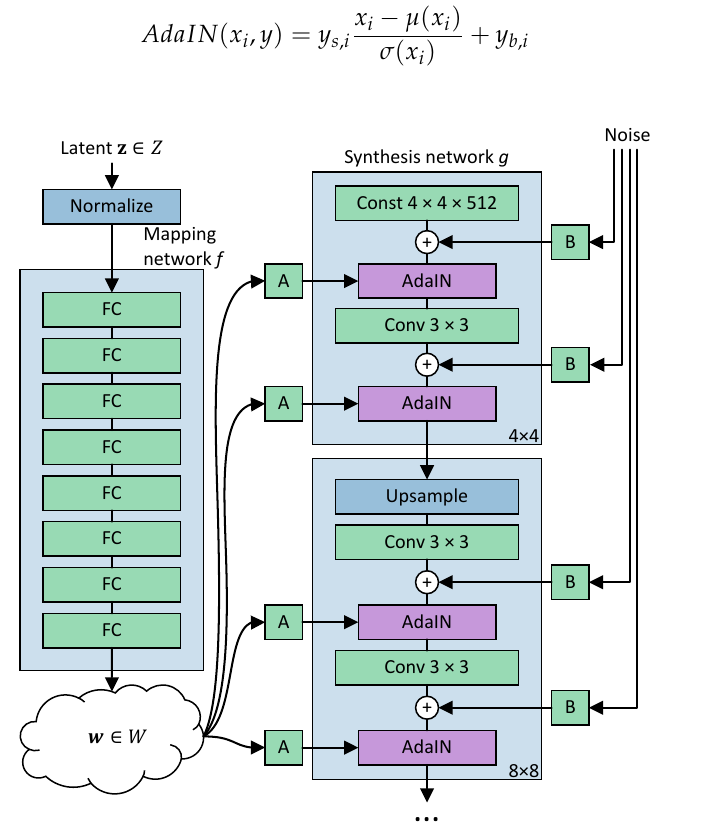
Figure 3. Generator architecture of the StyleGAN neural network